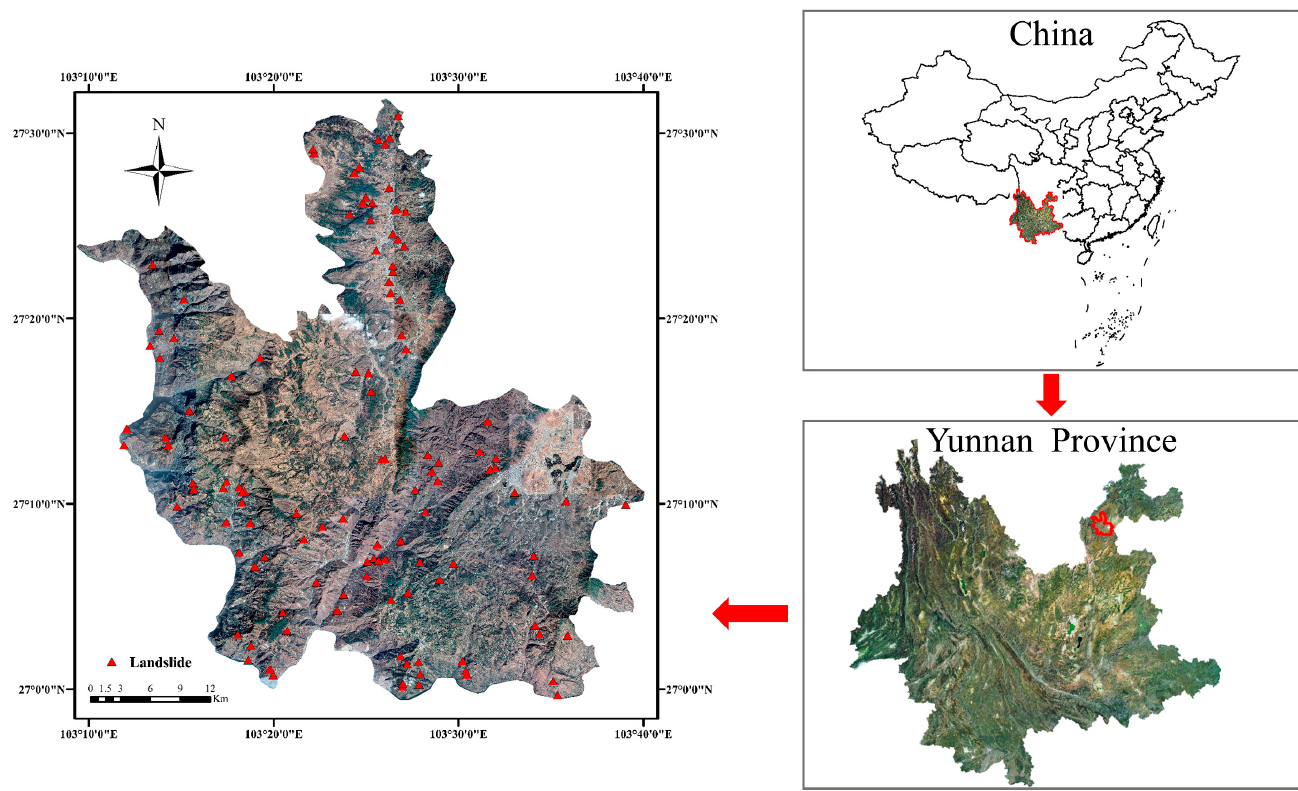
Figure 1. Location of the study area.